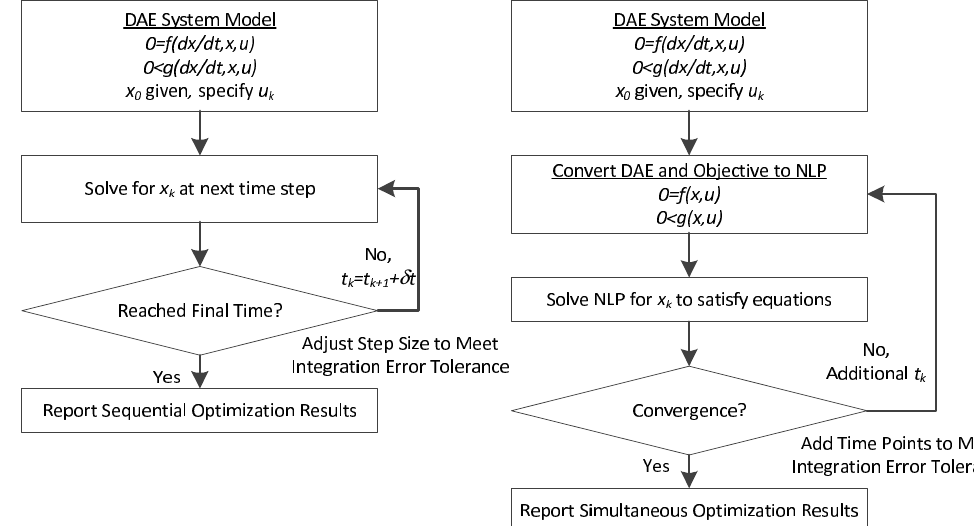
Figure 3. Overview of sequential ( left ) and simultaneous ( right ) approaches to solve DAE systems.